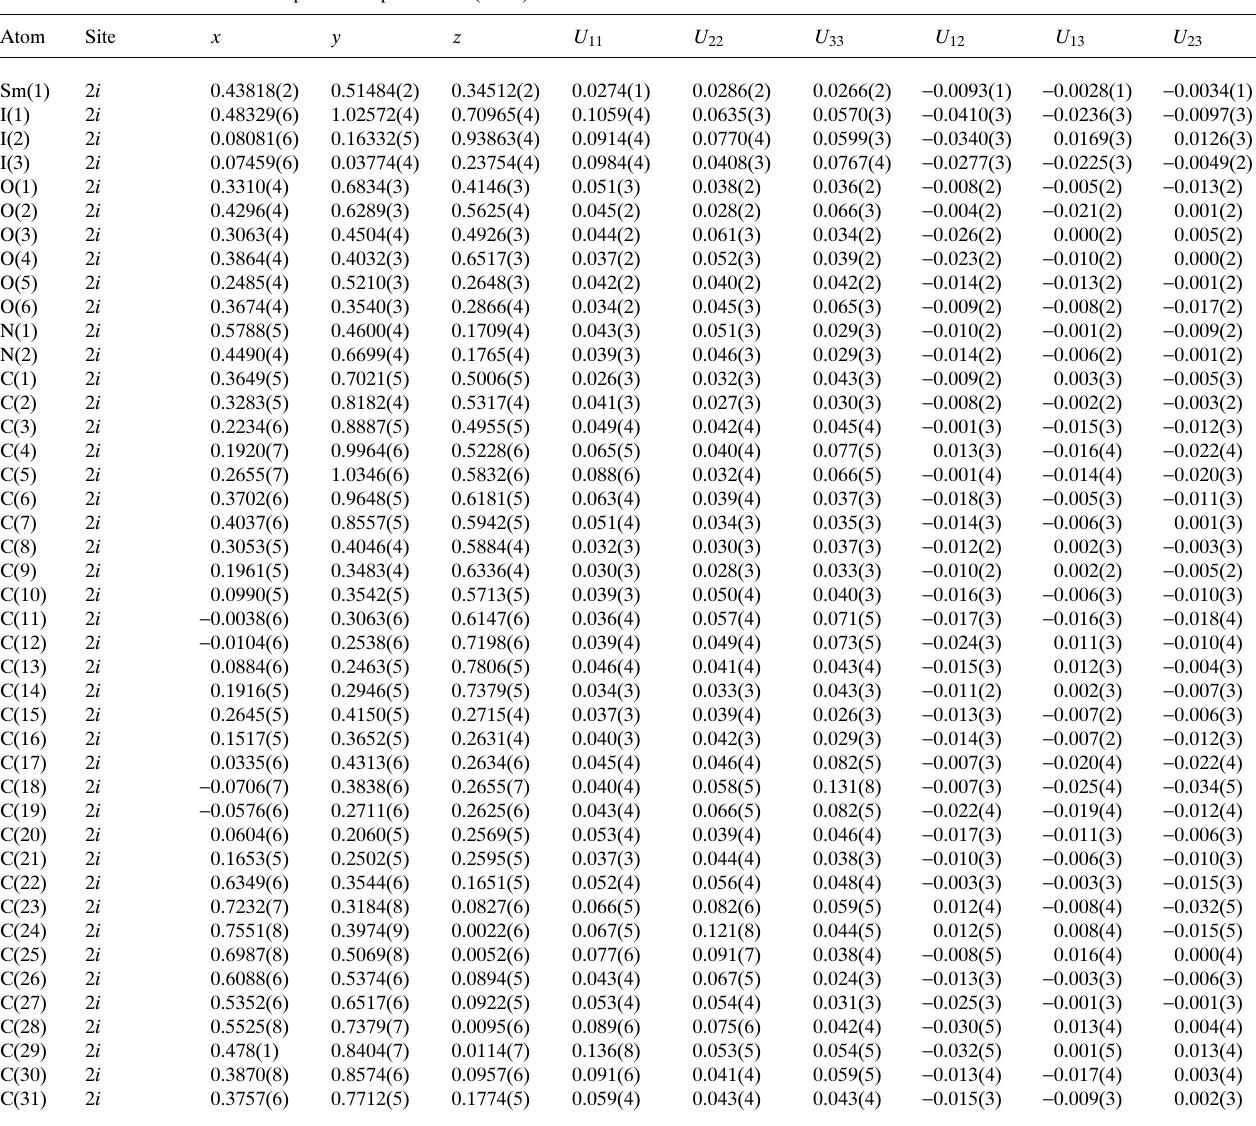
Table 3. Atomic coordinates and displacement parameters (in Å 2 ) .